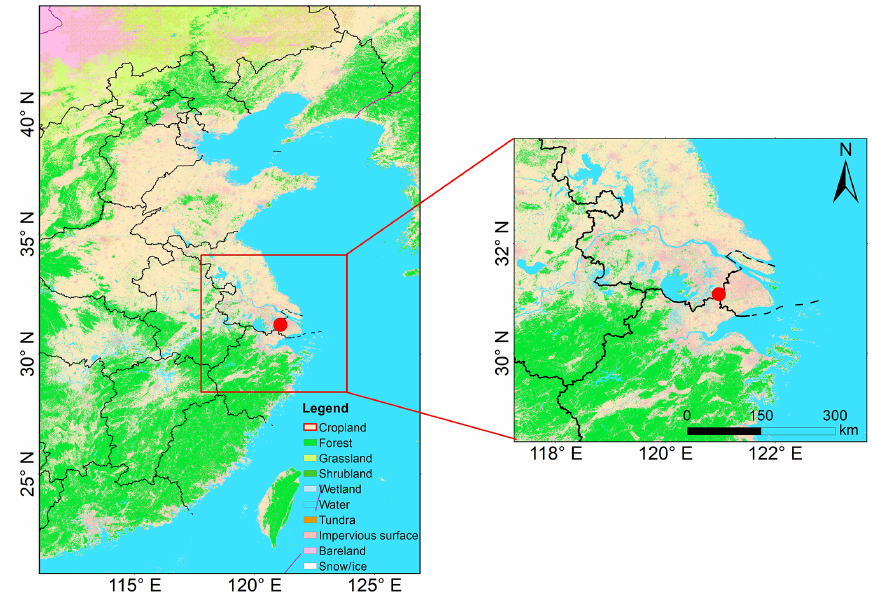
Figure 1. The location of the Dianshan Lake (DSL) site in Shanghai, China. Different colors in the map represent different land cover types.